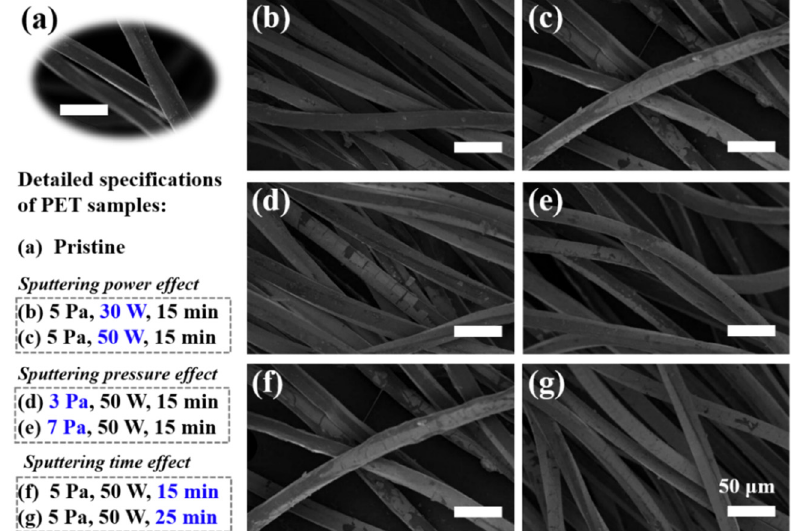
Figure 2: ( a ) The pristine PET fi ber; e ff ects of technological parameters, i.e., ( b and c ) sputtering power, ( d and e ) sputtering pressure, and ( f and g ) sputtering time on surface morphologies of fi